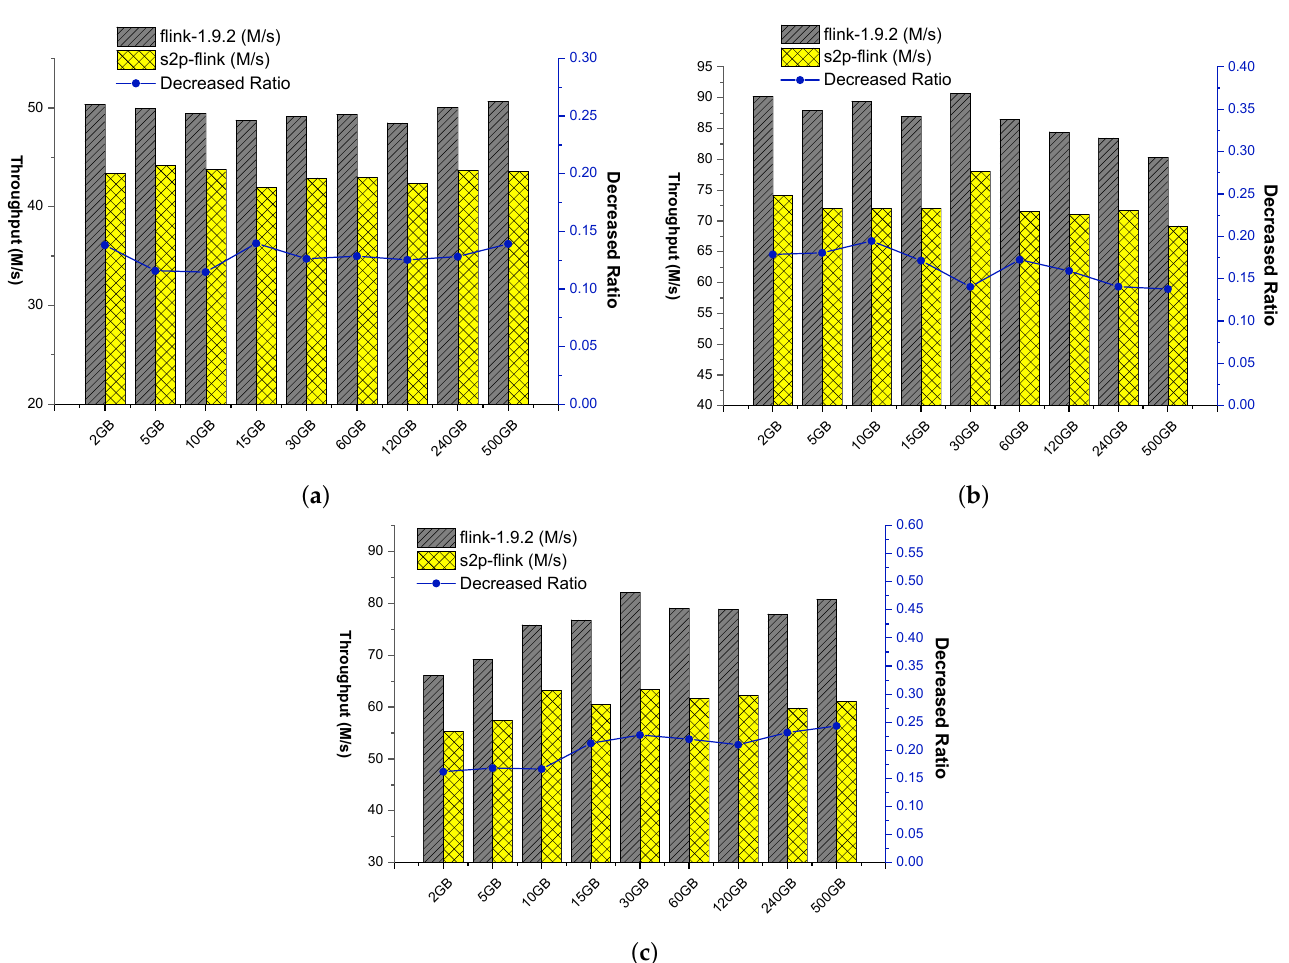
Figure 12. ( a ) P1 throughput results; ( b ) P2 throughput results; ( c ) P3 throughput